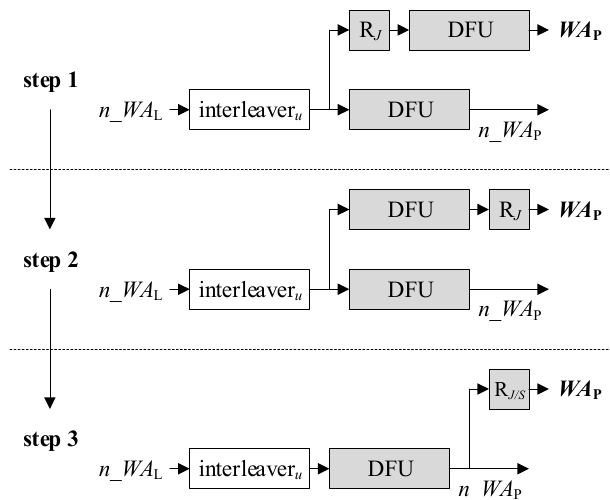
Figure 5. Step-by-step illustration of removing division-by- S -and-floor unit (DFU) from S-AGU.